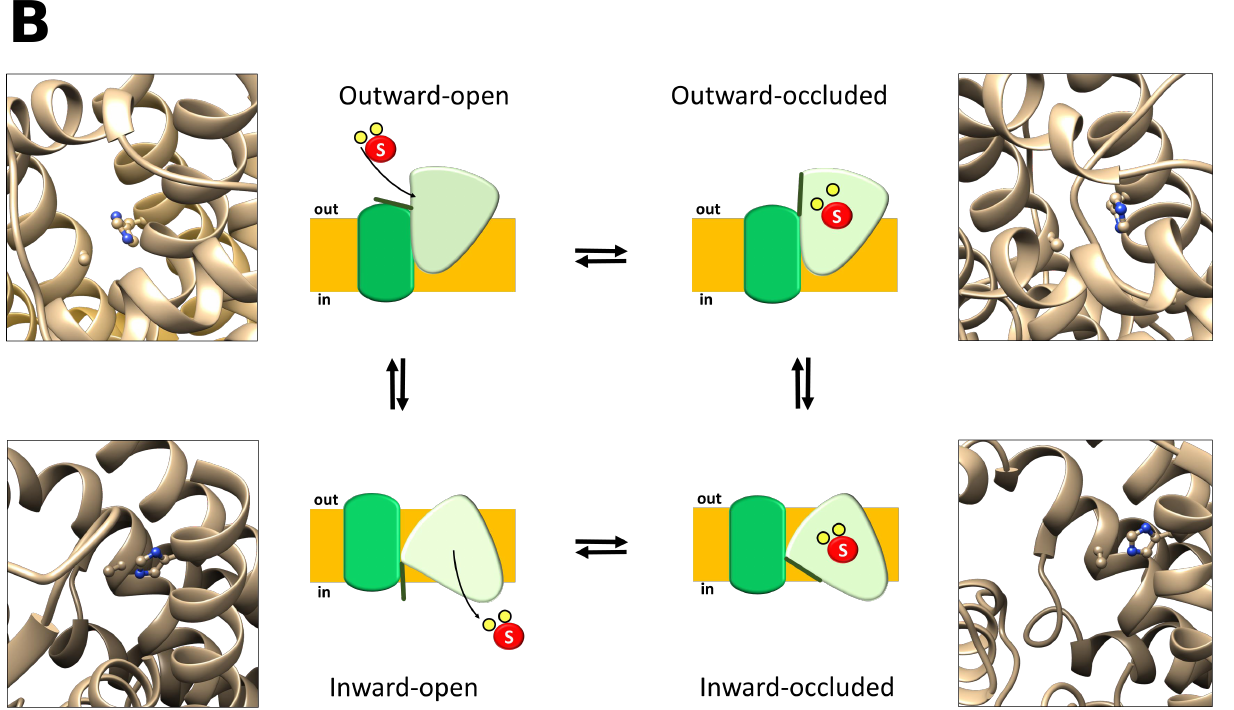
Figure 6. The hASCT2 predicted transport cycle. In the outward-open state, the hASCT2 binding site is accessible to the substrate to enter; after the binding of substrate, HP2 closes, and ASCT2 transit into the outward-occluded state. Subsequently, the transport domain moves towards the cytoplasm forming the inward-occluded state. After that, ASCT2 transits into the inward-open allowing substrate release into the cytoplasm. The last step is the transition towards the outward- open state that completes the cycle. The sketches of each step of the transport cycle are associated with the picture of the binding site derived from the 3D structures in the corresponding conformational state (see text). In ( A ), the antiport transport cycle of the WT protein; cysteine 467 and histidine 313 are depicted with a ball and stick representation. The distances between these two amino acids are reported in red. In ( B ), the unidirectional transport cycle of the C467A mutant protein. The C467 residue has been mutated in silico to alanine using UCSF Chimera 1.13.1 software; alanine 467 and histidine 313 are depicted with a ball and stick representation. In the figure, the sketch of one representative ASCT2 monomer with scaffold domain in dark green, scaffold domain in light green, internal substrate as blue “S”, external substrate as red “S” and 2 Na + ions in yellow balls. The membrane is indicated in orange and oriented with indication of “in” and “out”. In the boxes, images of 3D structures were generated using UCSF Chimera 1.13.1